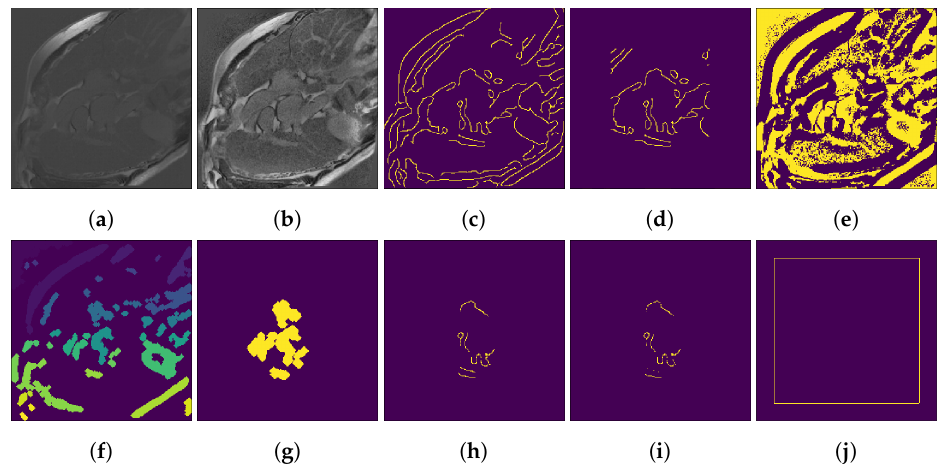
Figure 3. Example of automatically generating seeds from an input image. ( a ) Input image. ( b ) After adaptive histogram equalization. ( c ) Canny output. ( d ) ROI crop of Canny output. ( e ) Local Otsu output. ( f ) After applying cluster the area filter on Otsu output. ( g ) Otsu central components. ( h ) Canny intersected with central Otsu clusters. ( i ) After removing top 20% low-intensity pixels (final foreground seed). ( j ) Trivial background